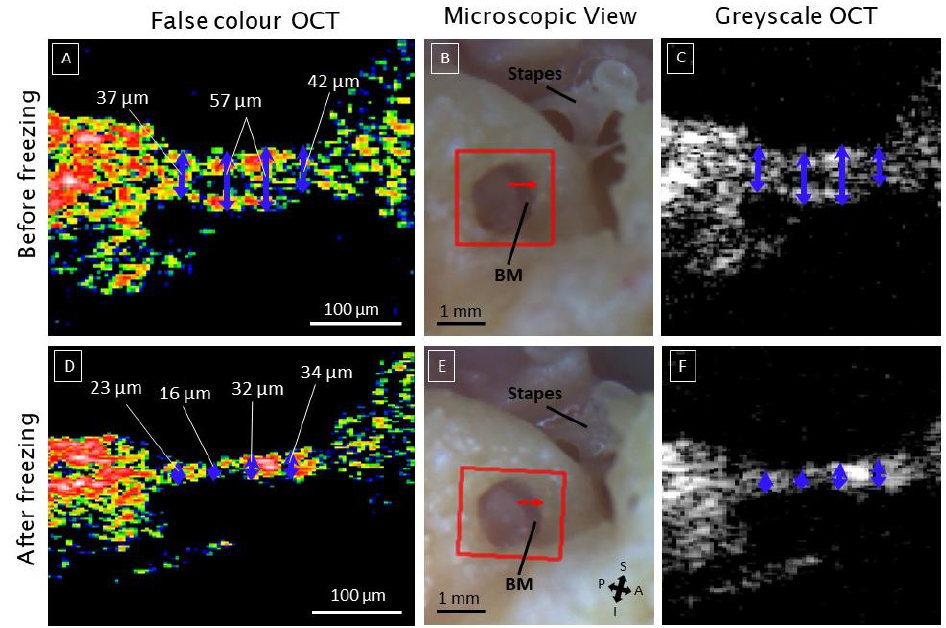
Figure 4. The disappearance of the hearing epithelium in the organ of Corti after freezing. This example is from the same sample at different scanning times. ( A ): the sample was first scanned after the release from the mortuary, and important landmarks within the OoC are visible, such as the ISS and TC. ( B , C ) are the corresponding microscopic and greyscale images, respectively. The red arrow indicates the location of the cross-section of the OCT images. ( D ): shows the same sample but at a later scanning date, where it was frozen and thawed again before the scanning. ( E , F ) are the corresponding microscopic and greyscale images, respectively. The blue arrows and corresponding thickness measures show how the freezing process altered the condition of the sensory epithelium. The a-scan rate of the OCT images was set to 76 kHz. Abbreviations; basilar membrane (BM), superior (S), inferior (I), anterior (A), and posterior (P).